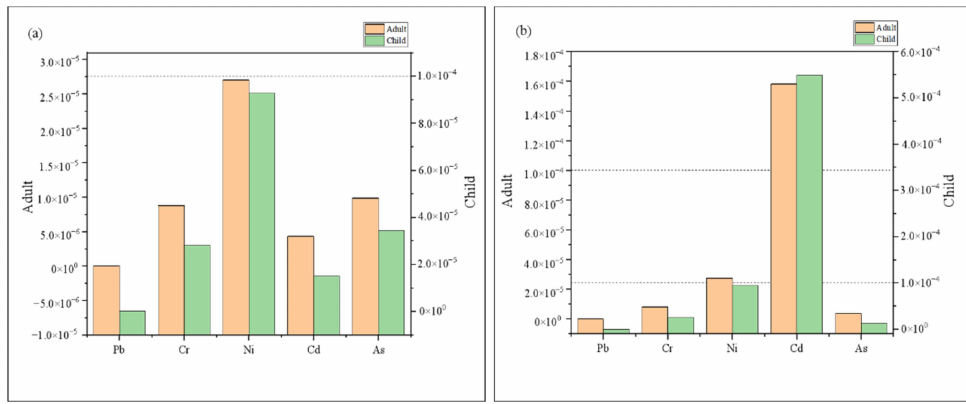
Figure 8. CR for adults and children during the wet ( a ) and dry ( b ) seasons.